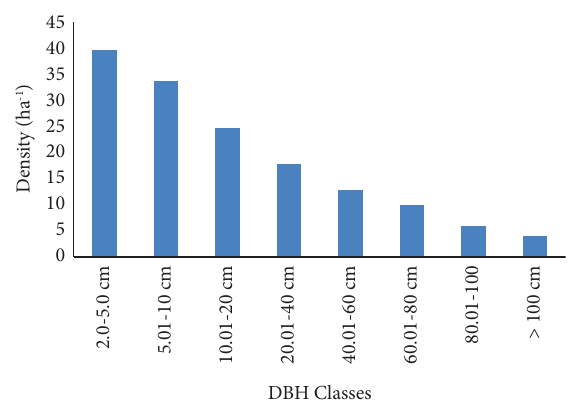
Figure 5: DBH distribution patterns (structure) of Juniperus procera in the Church